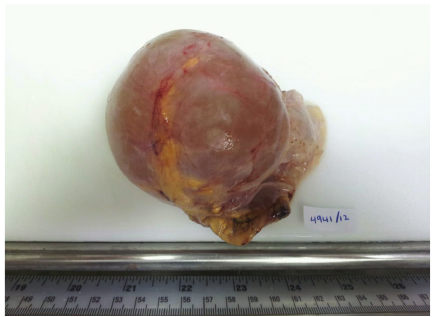
Figure 2: Macroscopic appearance of the specimen showing tense glistening grey brown cyst filled with clear fluid. Note the residual adrenal tissue attached to the external surface.